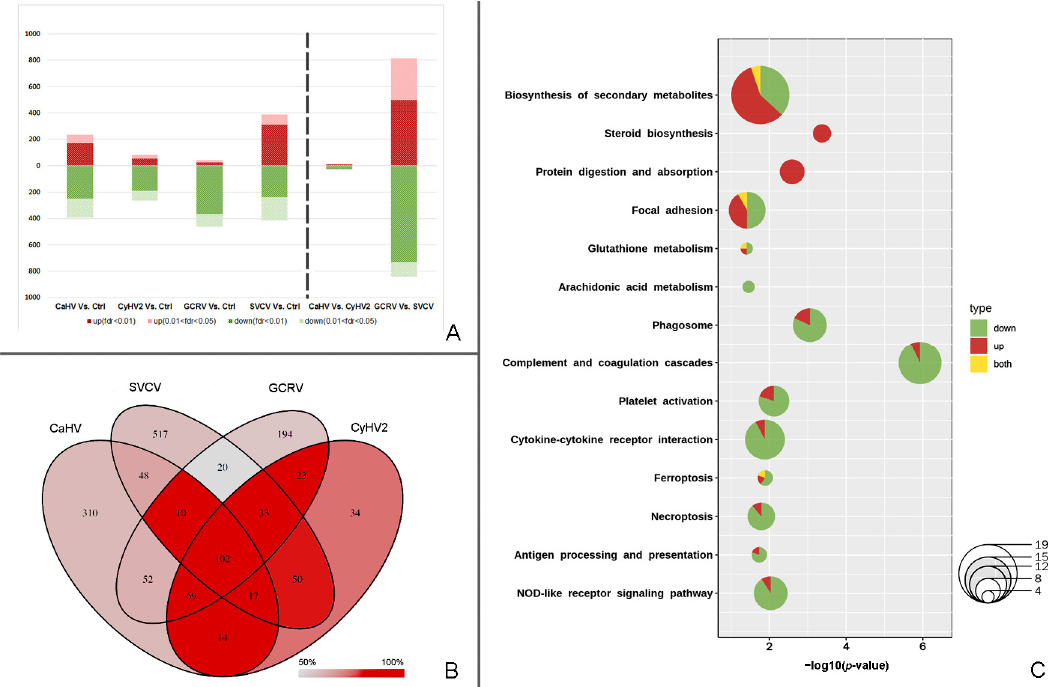
Figure 1. Summary diagrams of DEGs and PBGs. ( A ) Stacked bars of DEGs. ( B ) The Venn diagram of DEGs in the infections by four viruses. The depth of red is in accord with the proportion of PBGs. ( C ) Bubble pie chart of enriched pathways based on PBGs. Red indicates upregulated PBGs, green indicates downregulated PBGs, and yellow indicates genes with multiple copies, some of which are upregulated and the others